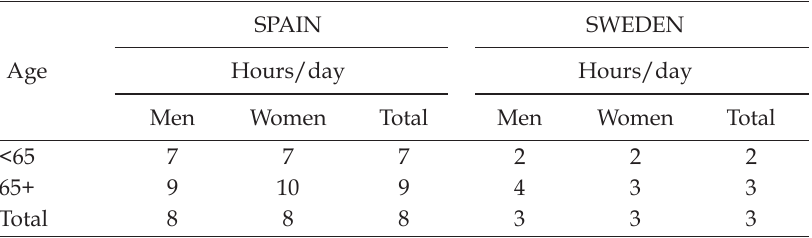
Table 3. Hours of caregiving among caregivers, by gender and age group, Spain and Sweden, 2014